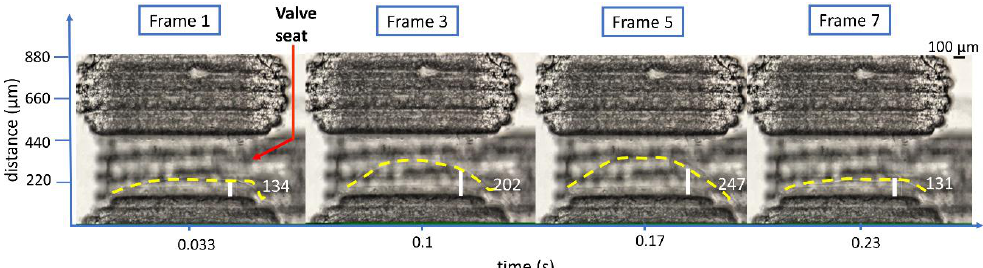
Figure 2. Frequency calculation using ImageJ software. The distance from an edge of the valve seat and the membrane contour (yellow dashed curve) against the PMMA surface is measured for each movie frame of the oscillation. The time interval between similar distances provides the oscillation period. Frames 1 and 7 have similar distances of 134 µm and 131 µm, respectively, corresponding to a period of six frames or a 0.2 s oscillation period (Multimedia view).